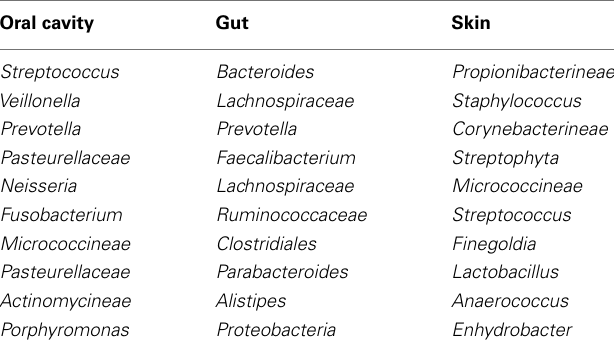
Table 2 | Bacteria commonly found on the surfaces of the human body (64)